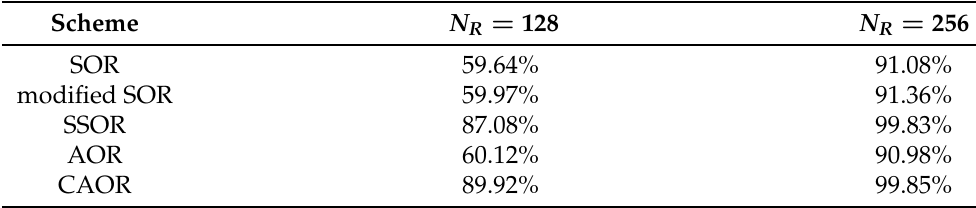
Table 5. BER improvement rate of different detection schemes when i = 2 and SNR = 40 dB for N R = 128 and N R = 256. (Compared with N R =